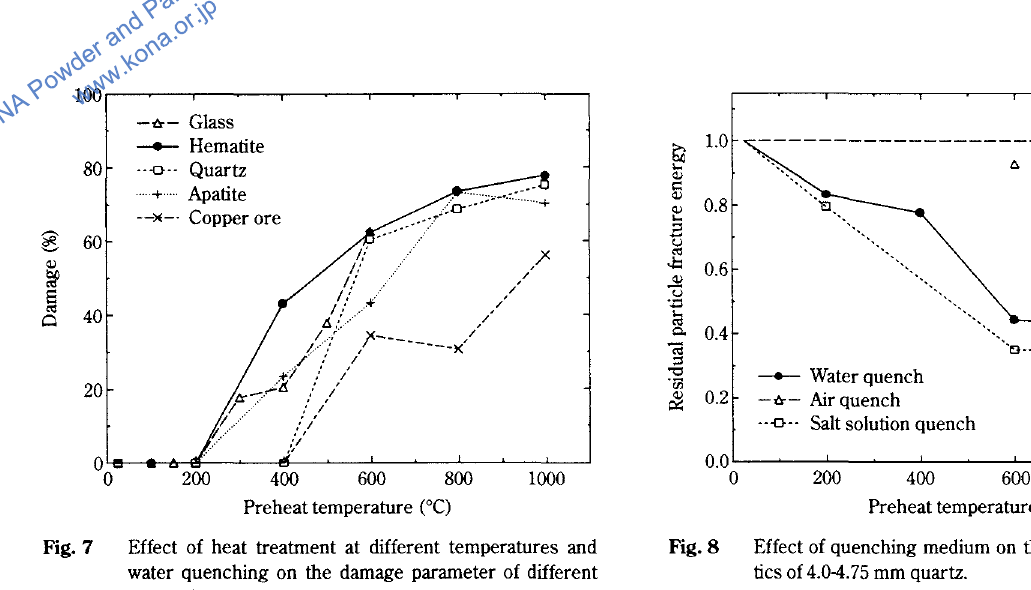
Effect of heat treatment at different temperatures and water quenching on the damage parameter of different materials